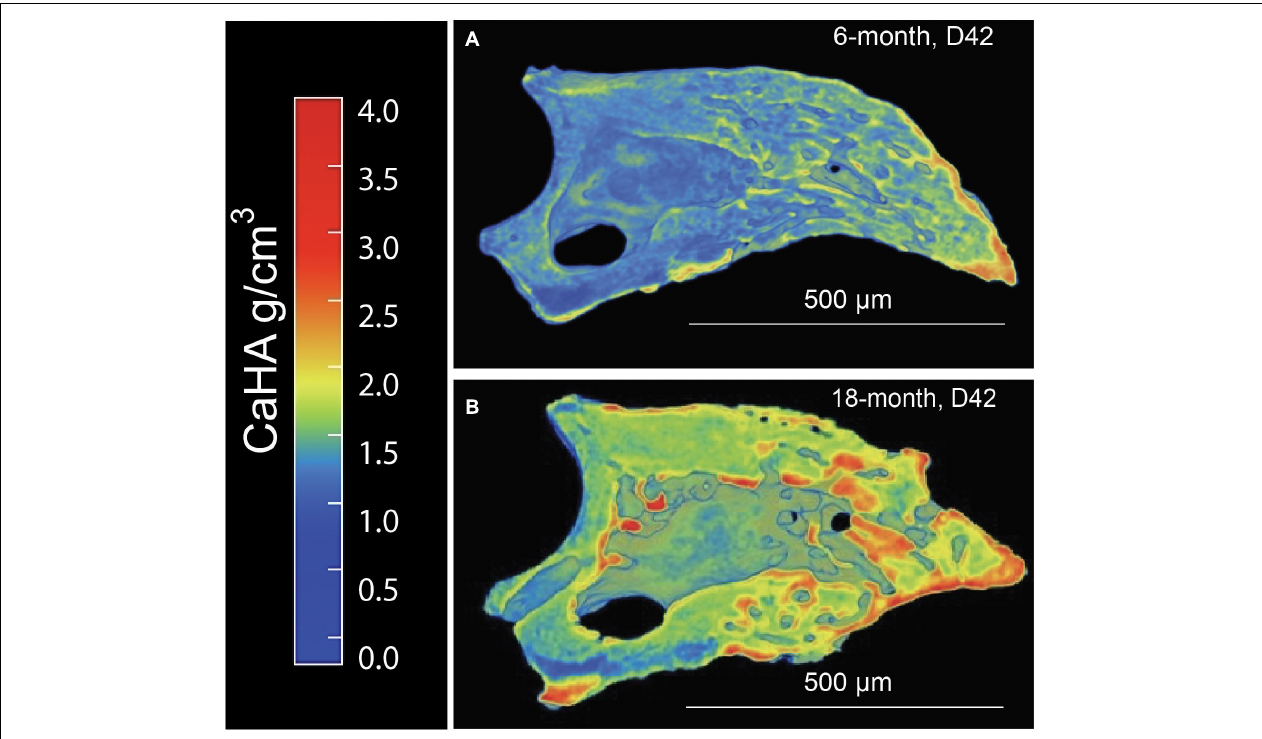
FIGURE 3 | Distribution of calcium hydroxyapatite (CaHA) in microCT cross-sections of a (A) 6-month and (B) 18-month regenerated bone (D42). N = 11–14 digits. A representative sample is shown.